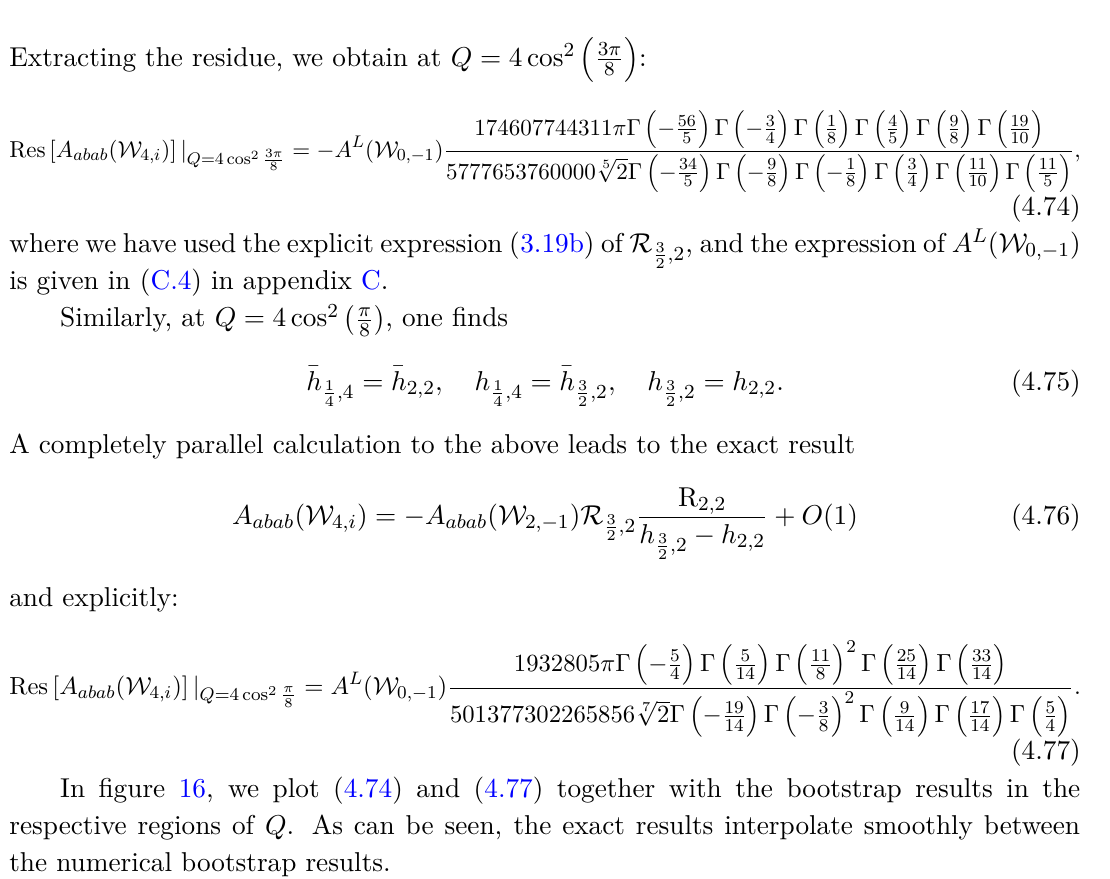
Figure 16 . The residues of the amplitude A abab ( W 4 ,i ) at Q = 4 cos 2 (right) given by the exact expressions (4.74) and (4.77) are indicated with black dots. The slightly smaller blue dots are the bootstrap results in the nearby